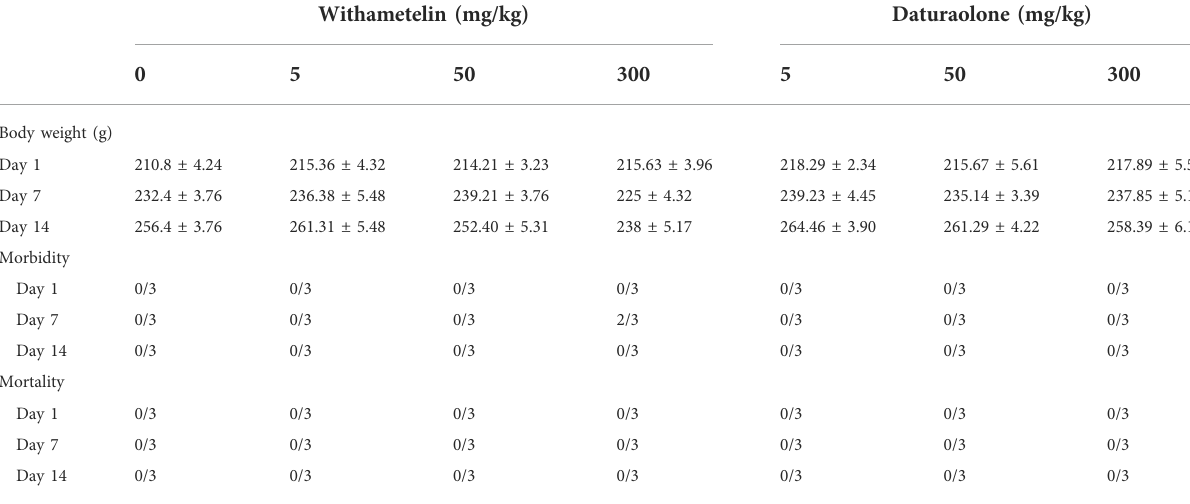
TABLE 2 Body weight, morbidity, and mortality after acute toxicity studies of withametelin and daturaolone at selected